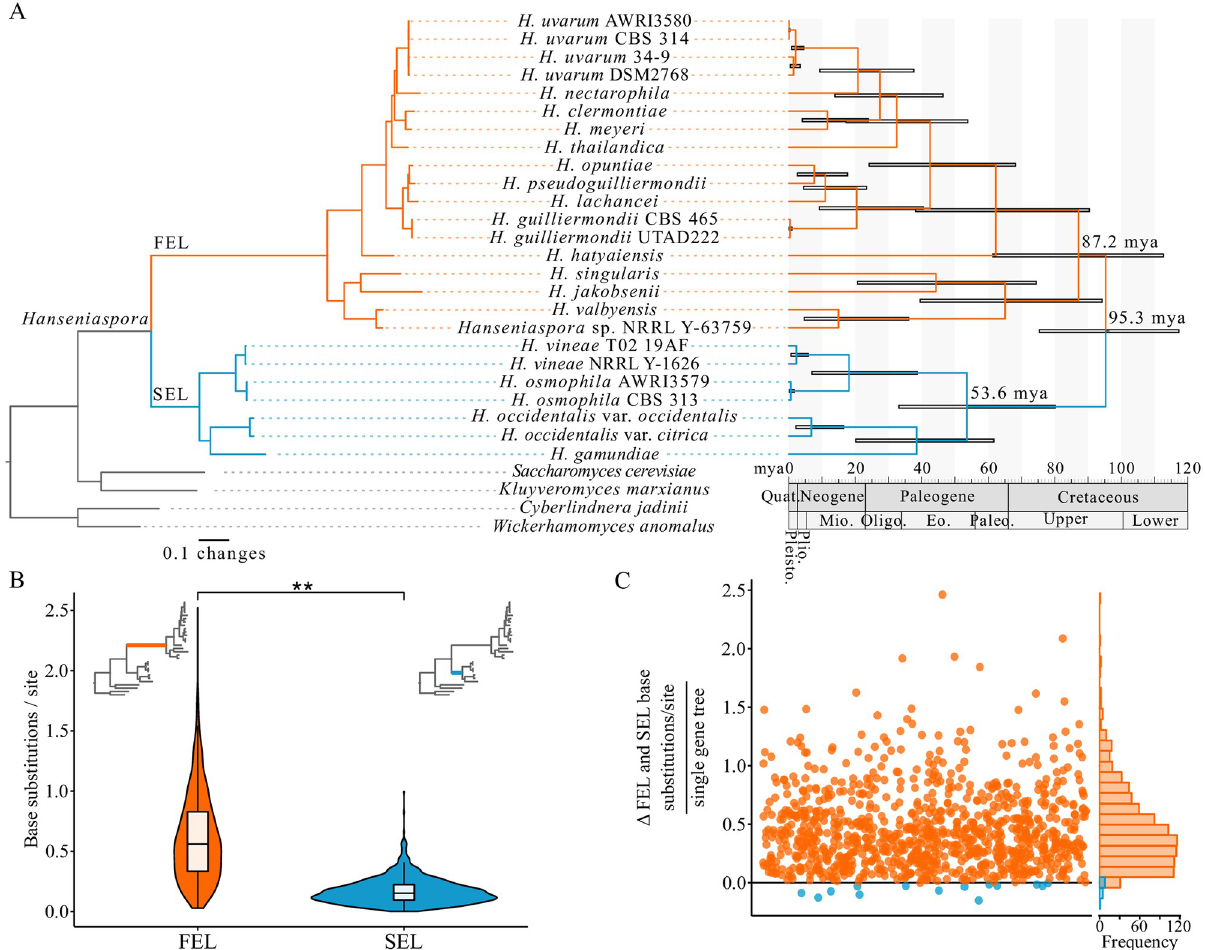
Fig 1. The evolutionary history, rate, and timeline of Hanseniaspora diversification. (A) Phylogenomic and relaxed molecular clock analysis of 1,034 single-copy OGs from a near-complete set of Hanseniaspora species revealed two well-supported lineages termed the FEL and SEL, which began diversifying around 87.2 and 53.6 mya after diverging 95.3 mya. (B) Among single-gene phylogenies in which the FEL and SEL were monophyletic ( n = 946), the FEL stem branch was consistently and significantly longer (0.62 ± 0.38 base substitutions/site) than the SEL stem branch (0.17 ± 0.11 base substitutions/site) ( p < 0.001; paired Wilcoxon rank–sum test). (C) Examination of the difference between FEL and SEL: stem branch lengths per single-gene tree revealed that 932 single-gene phylogenies had a longer FEL stem branch (depicted in orange with values greater than 0), while only 14 single-gene phylogenies had a longer SEL stem branch (depicted in blue with values less than 0). Across all single-gene phylogenies, the average difference in stem branch length between the two lineages was 0.45. figshare: https://doi.org/10.6084/m9.figshare.7670756.v2. AWRI, Australian